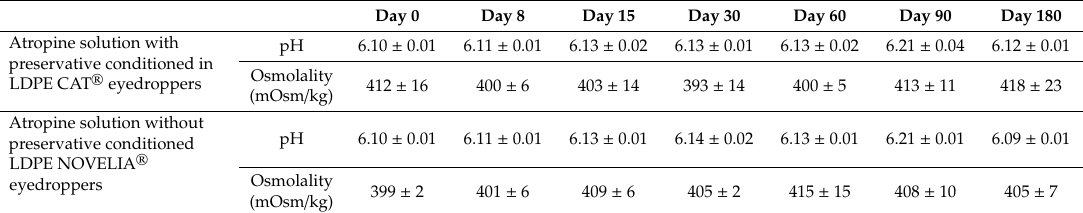
Table 5. Evolution of pH and osmolality over time ( n = 5, mean ± 95% confidence